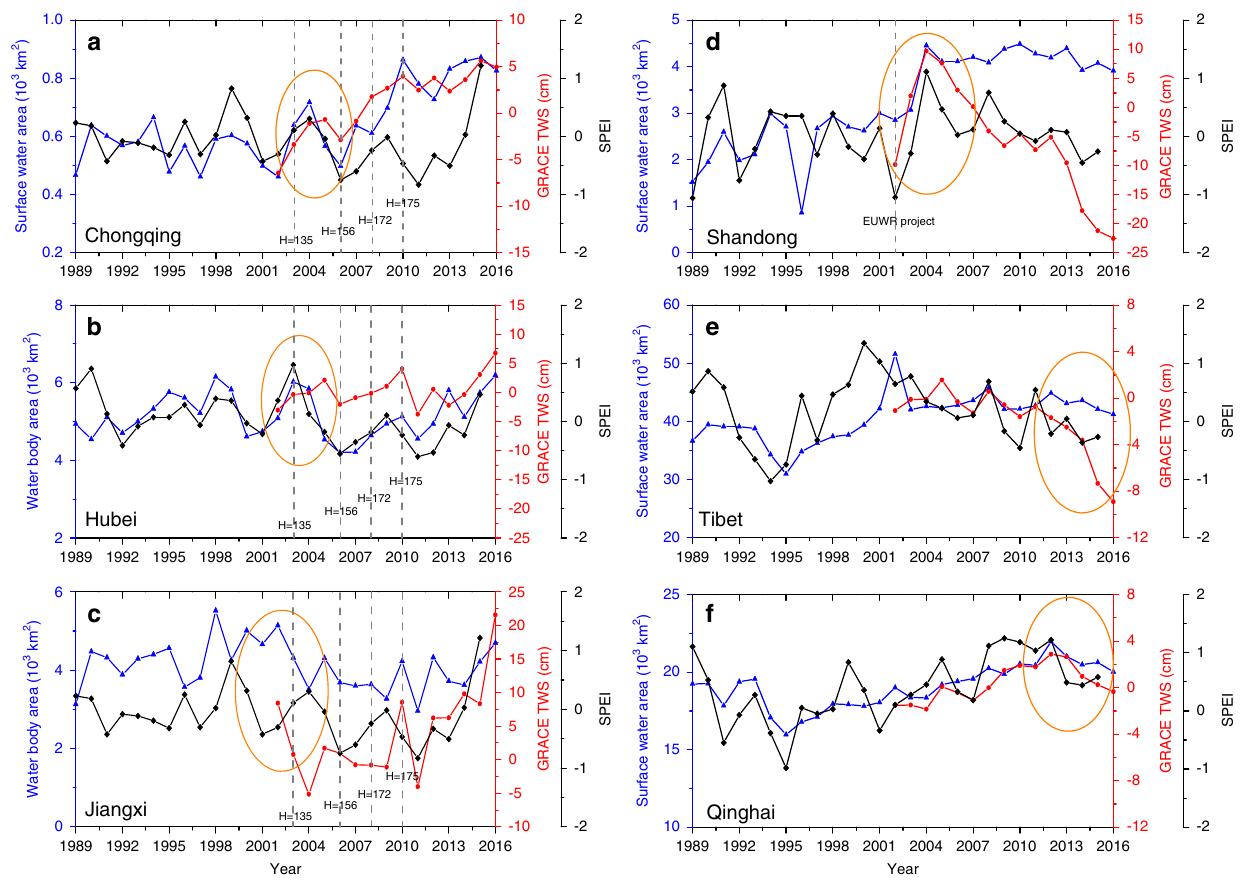
Fig. 4 Surface water area, terrestrial water storage, and the standardized precipitation – evapotranspiration index at the provincial scale. a Chongqing. b Hubei. c Jiangxi. d Shandong. e Tibet. f Qinghai Province. The SPEI is the standardized precipitation-evapotranspiration index. The dashed lines and the numbers in sub fi gure ( a – c ) showed the water level (H) of the Three Gorge Reservoir and their corresponding years. The EUWR project in Shandong Province is the Ecological Urgent Water Replenishing (EUWR) project to divert water from the Yangtze River to Nansihu Lake during 2002 –